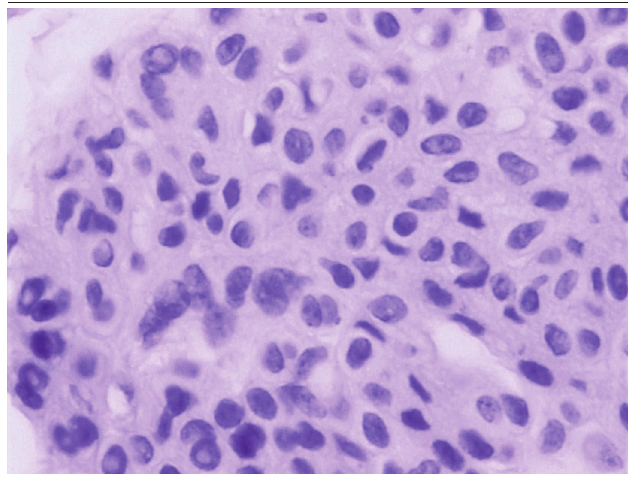
fIgure 2 – Vulvar melanocytic nevus; HE, 100× HE: hematoxylin and